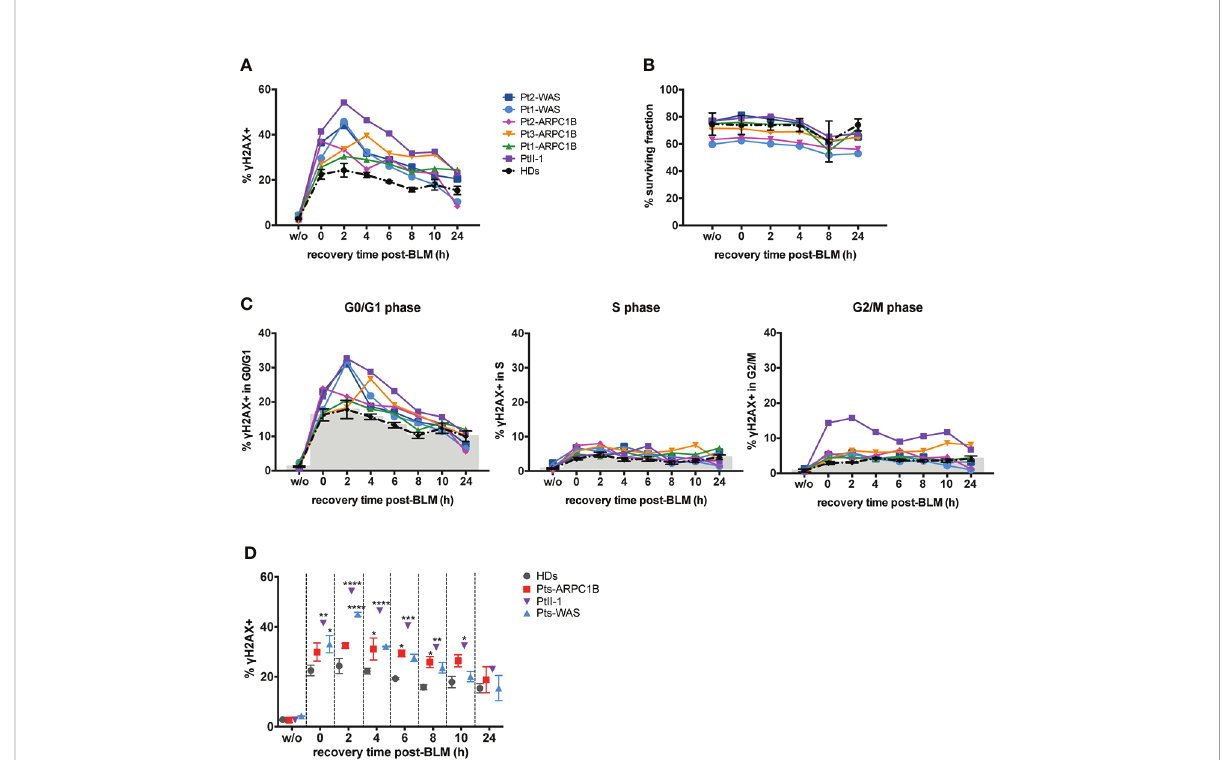
FIGURE 3 Repair-time kinetics of the cell survival fraction after BLM treatment. Kinetic experiment on untreated or BLM-treated EBVB cells from PtII-1, Pt1-3 ARPC1B patients, two WAS patients, and four HDs, investigated during 24 h of recovery time culture. (A) The graph shows the percentage of g H2AX + EBVB cells. (B) Cell survival fractions were reported as the percentage of 7AAD − EBVB cells. (C) Amount of g H2AX + EBVB cells in each cell cycle phase: G0/G1 (left panel), S (middle panel), and G2/M (right panel). Black line indicates the mean ± SEM of the four HDs. (D) Percentage of g H2AX + EBVB cells were reported as mean ± SEM calculated for each disease group (three ARPC1B patients and two WAS patients) and PtII-1 against HD group. Statistical signi fi cance was calculated with two-way ANOVA and Bonferroni ’ s posttest: * p < 0.05, ** p < 0.01, *** p < 0.001, and **** p <